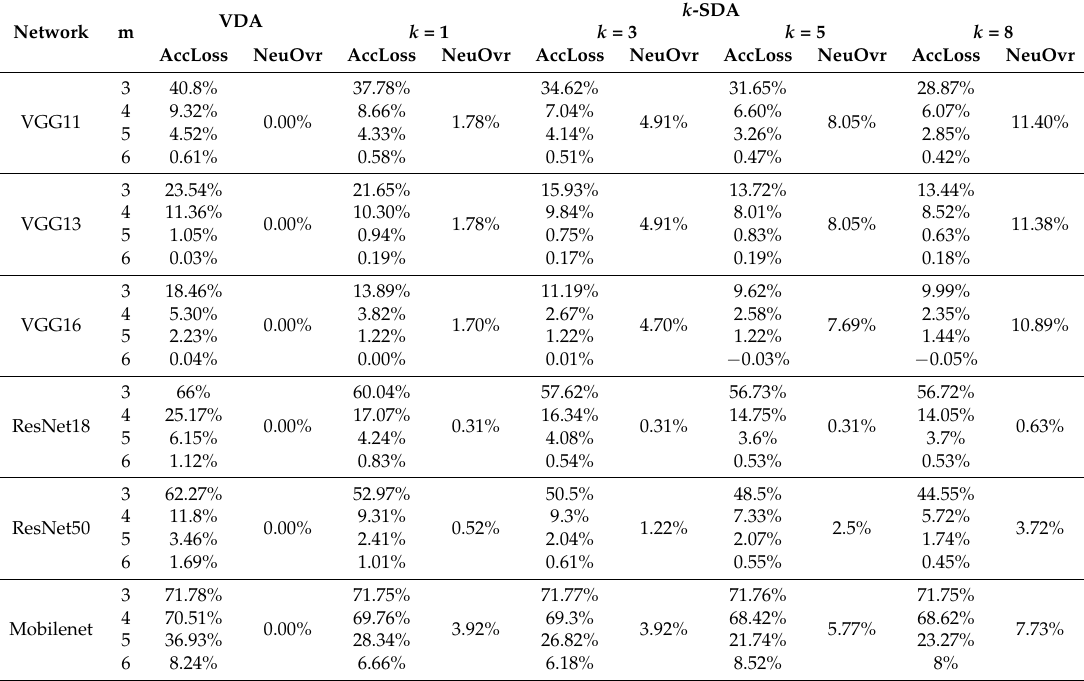
Table 1. Accuracy loss and neuron overhead of VGG11, VGG13, VGG16, ResNet18, ResNet50 and Mobilenet_v2 for neural network decomposition